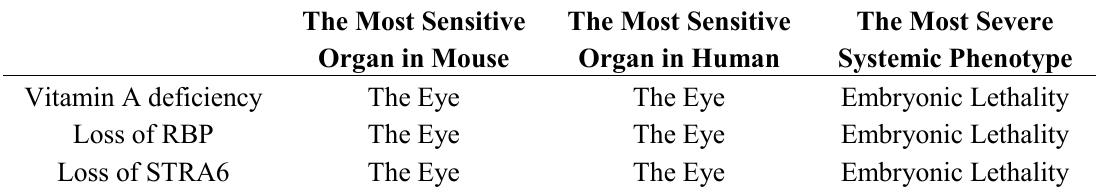
Table 6. In both mice and humans, the eye is the organ most sensitive to vitamin A deficiency, loss of RBP, or loss of